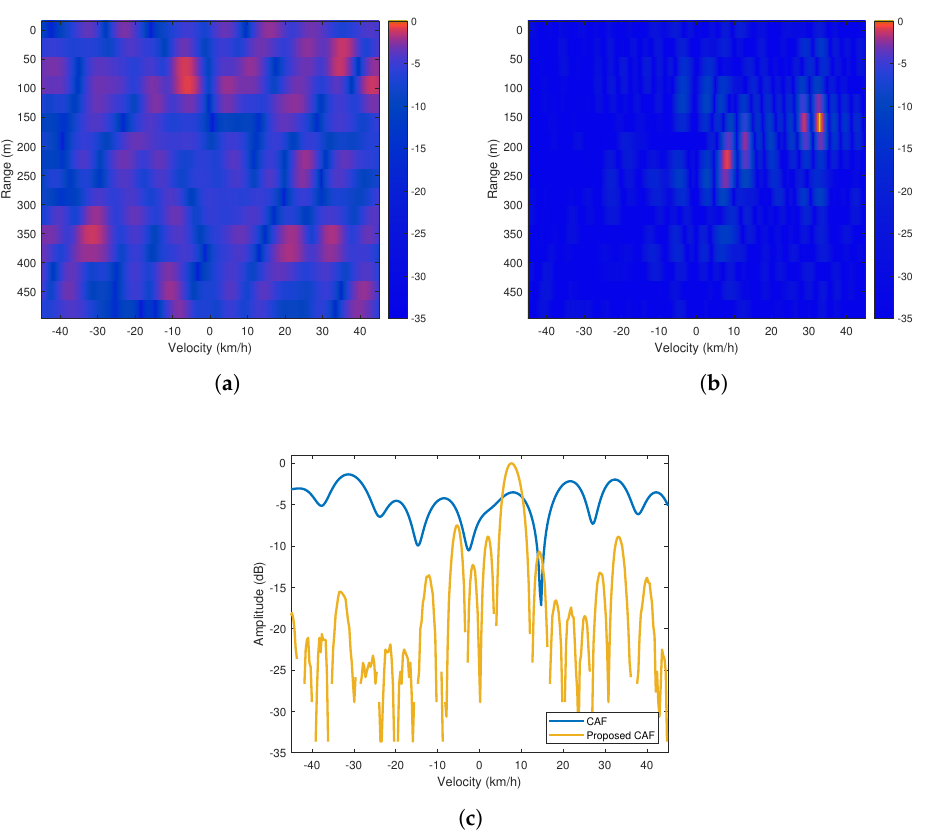
Figure 14. ( a ) CAF range-Doppler map ( b ) Proposed method’s range-Doppler map ( c ) Doppler profiles of the maps at 160